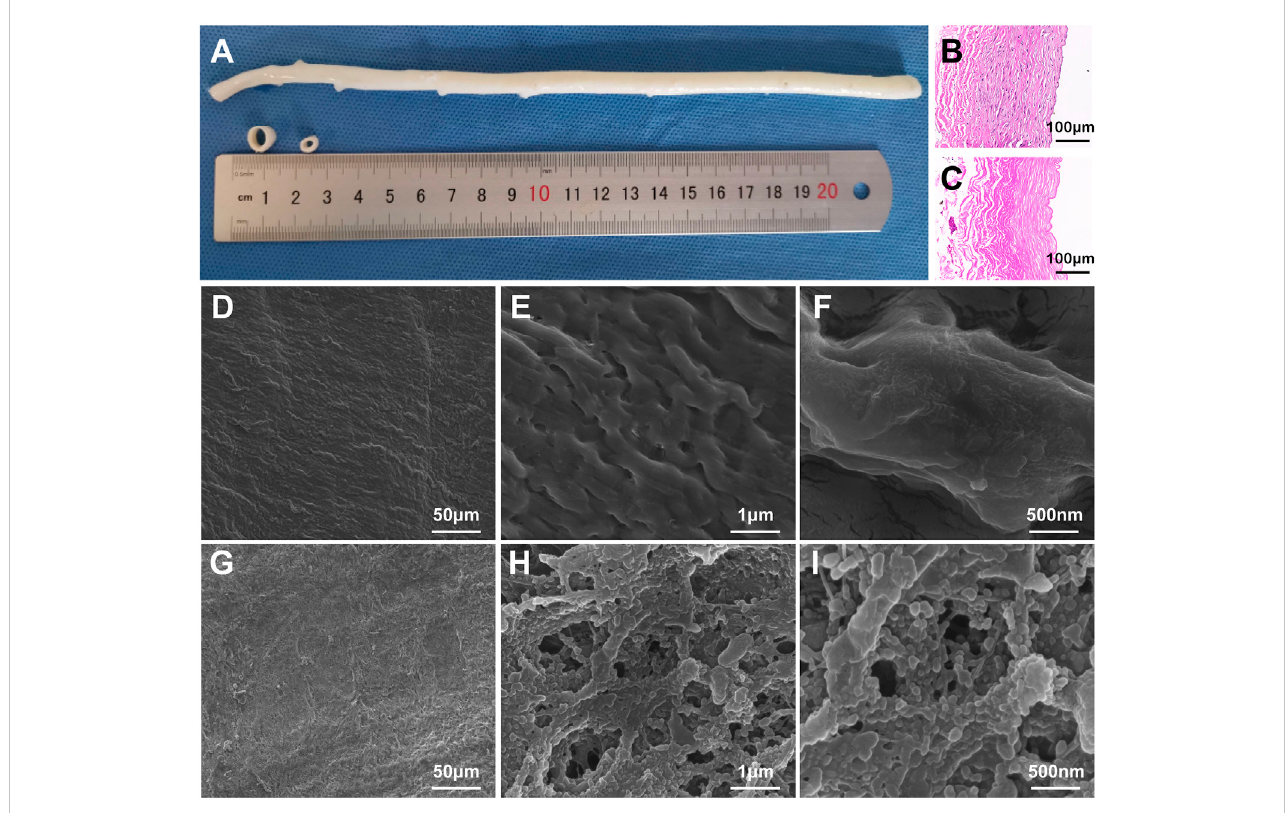
FIGURE 2 The characteristics of bovine internal mammary arteries (BIMA). (A) is the general view of fresh BIMA. (B,C) are the H&E staining of fresh BIMA and decellularizedandphoto-oxidizedBIMA(DP-BIMA). (D – F) are theSEM images offreshBIMA. (G – I) are theSEM images ofCS-REDV-Nps-VEGFmodi fi edDP- BIMA. Scale bars are indicated in each